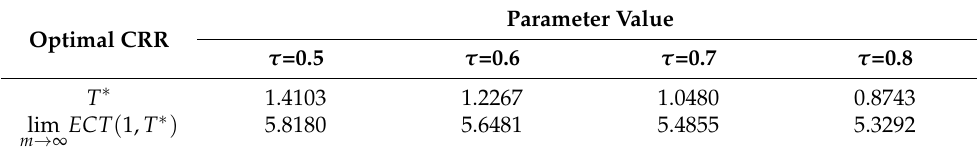
Table 1. The impacts of τ on the optimal CRR.